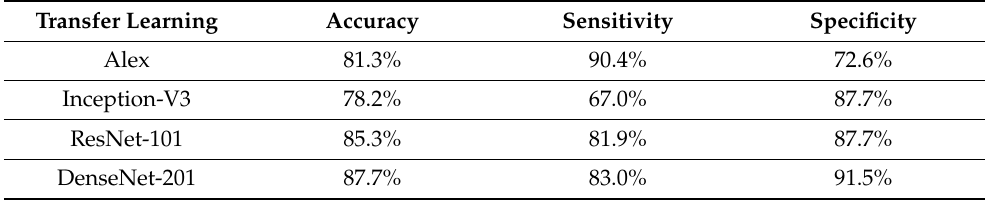
Table 3. The performances of various convolutional neural networks using transfer